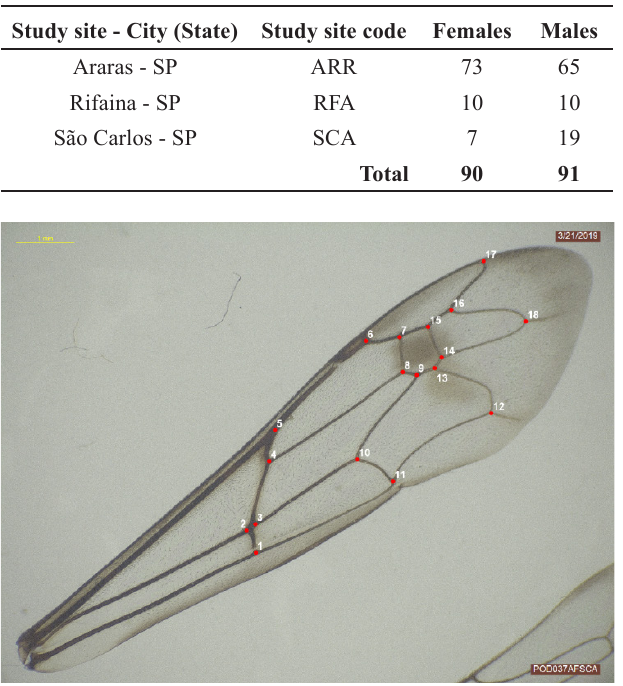
Fig 1 . Right forewing of a female of Podium denticulatum with 18 landmarks plotted at the vein intersections.